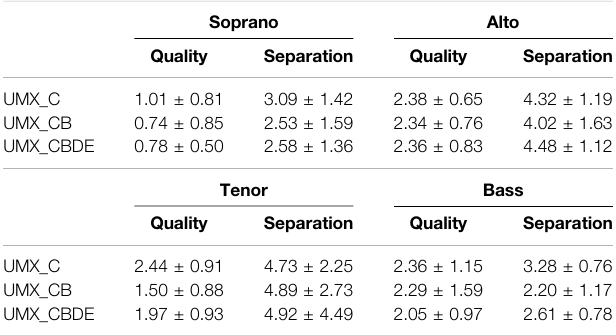
TABLE 8 | Normalized MOS results of the subjective listening tests pertaining to the separation and quality criteria.